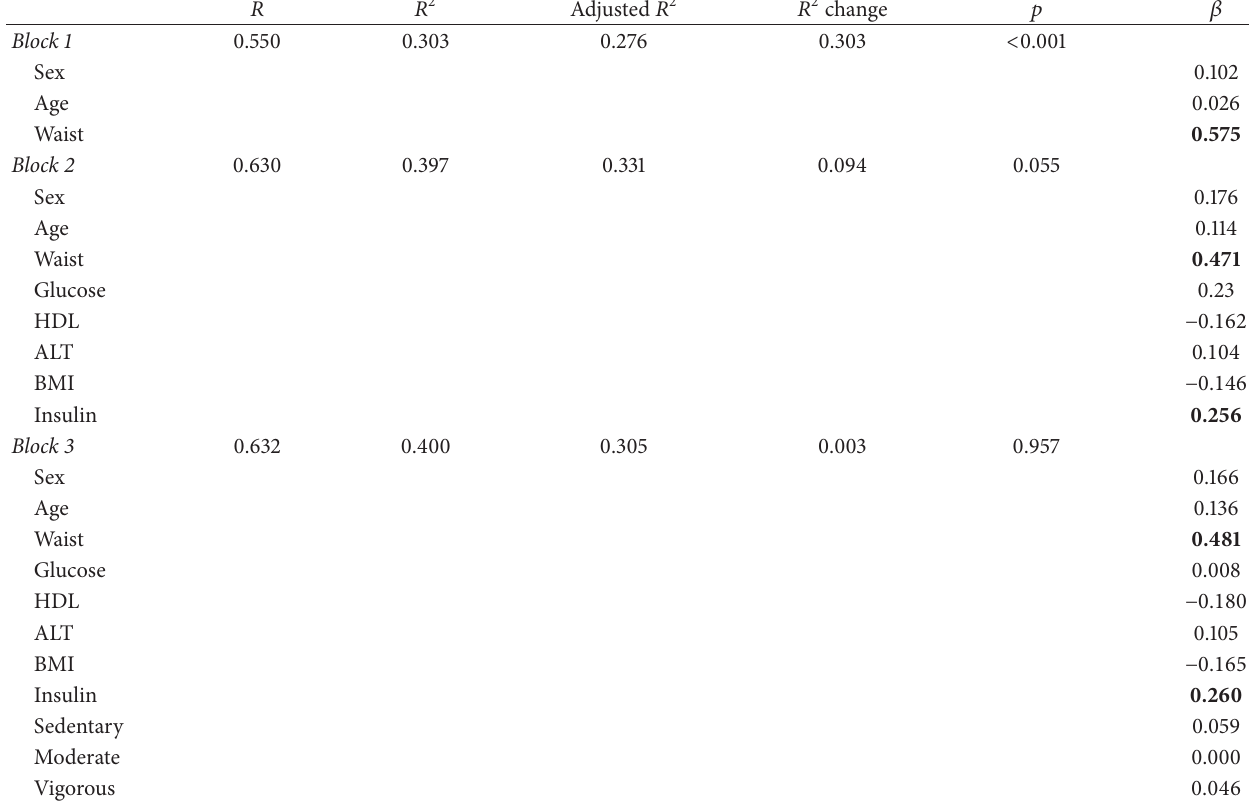
Table 4: Hierarchical regression model for prediction of liver